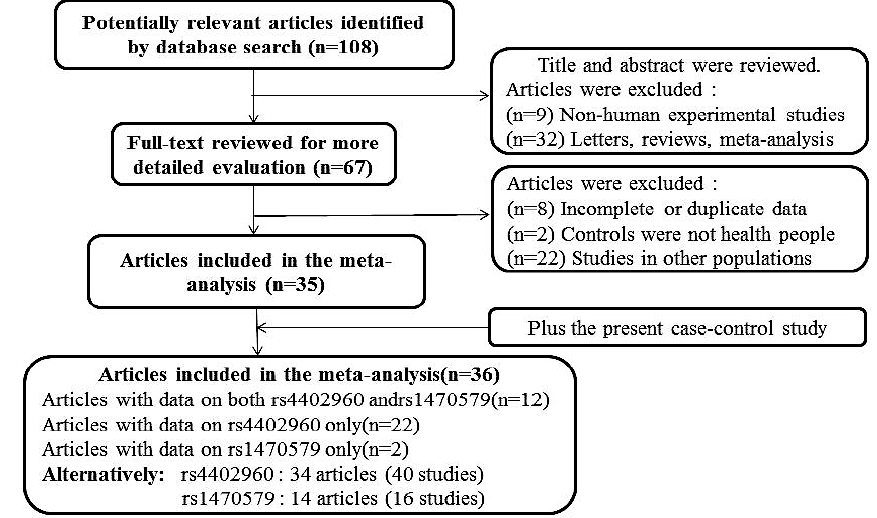
Figure1. Flow chart of the literature search and study selection. Figure 1. Flow chart of the literature search and study